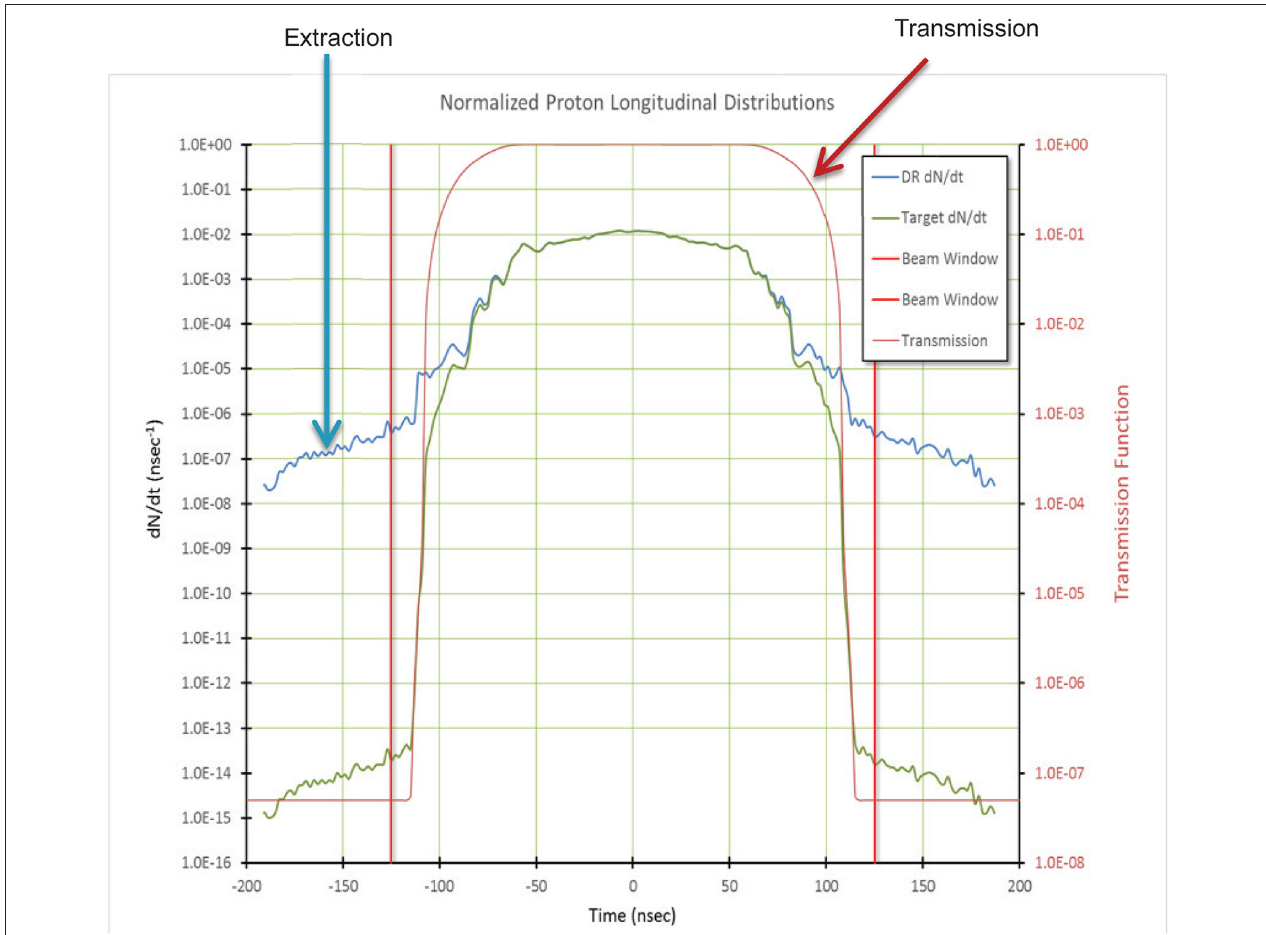
FIGURE 7 | Performance of the AC dipole system. The black line (scale at left) shows the transmission curve of the external dipole/collimator system, based on a G4Beamline simulation [ 31]. The green curve (scale at right) shows the ESME [32] simulation of the beam extracted from the Delivery ring. The blue curve shows the convolution of the two. Updated from Bartoszek et al. [ 8], courtesy of E. Prebys and the Mu2e